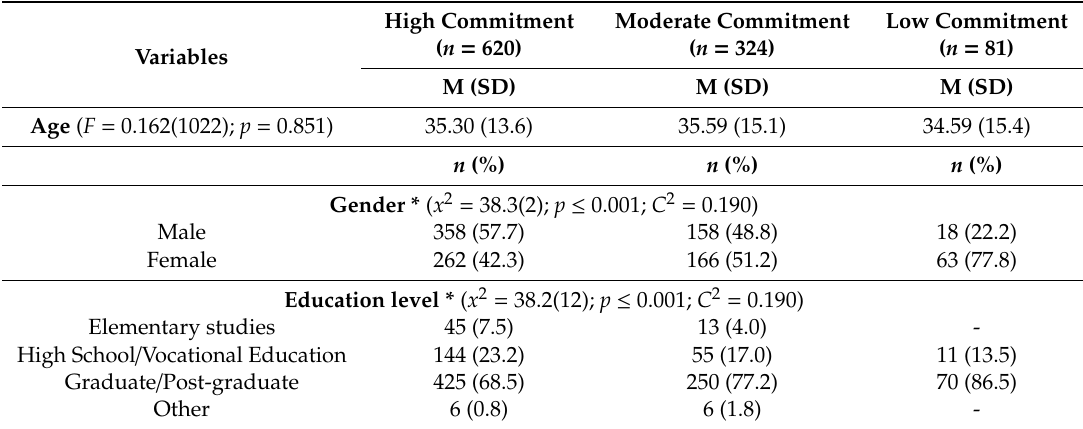
Table 5. Characteristics of the di ff erent